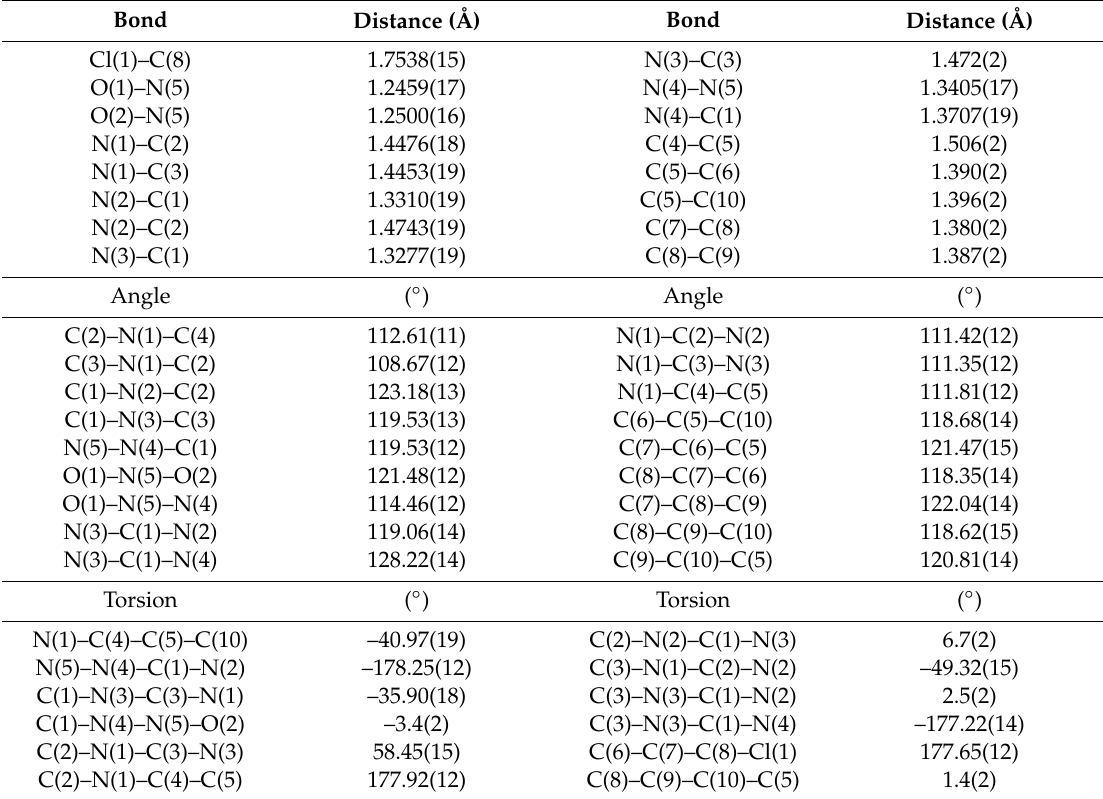
Table 2. Selected molecular structure